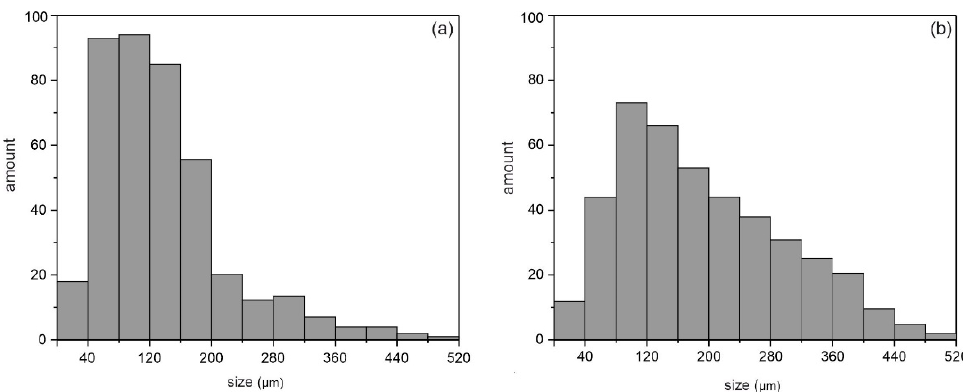
Figure 4. Size distribution histogram of interpore bridges of porous NiTi-(Ar) ( a ) and NiTi-(N) ( b ) alloys obtained by the SHS.